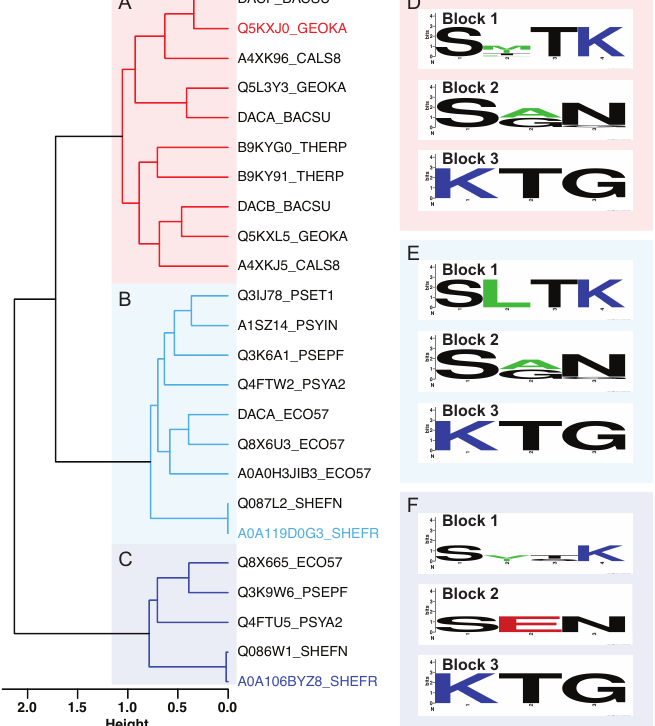
Figure 1. Microbial S11 proteases clustered according to protein sequence similarity. The sequences are described by three clusters. The thermophilic and psychrophilic sequences are separated, whereas mesophilic sequences are distributed among the three. Cluster ( A ) contains thermophilic sequences as well as those from B. subtilis . Clusters ( B , C ) comprise proteins from psychrophilic organisms, P. fluorescens and E. coli . The highlighted sequence name in each cluster indicates the centroid in sequence space. Panels ( D – F ) contain sequence logos associated with the three conserved active residue sequence blocks for each protein